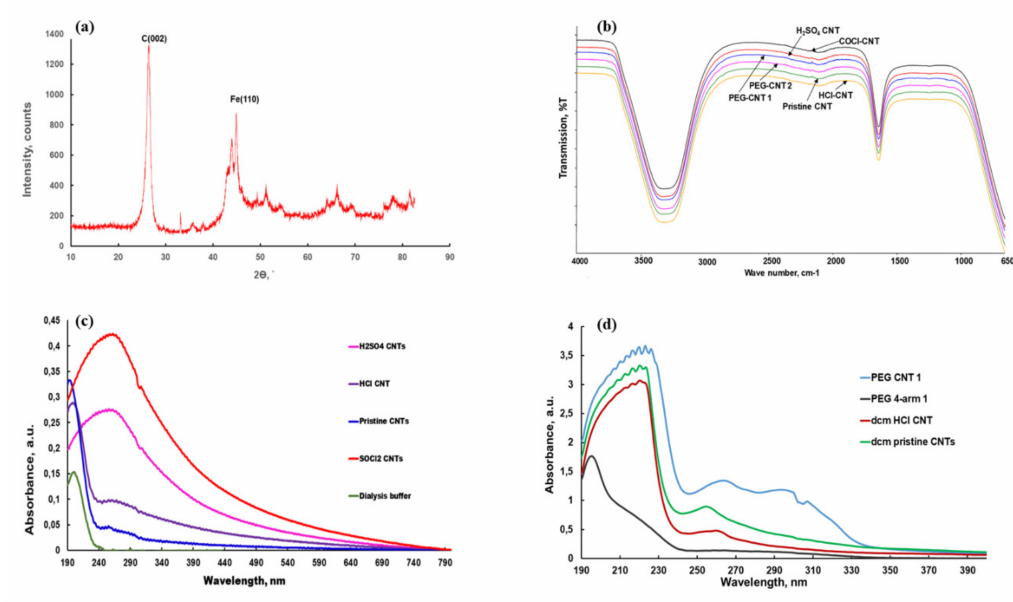
Figure 4. Si wafer XRD and IR spectra of VA-MWCNTs. XRD spectrum of Si wafer ( a ), universal attenuated total reflectance (UATR)-IR spectra of CNTs in water ( b ), UV-Vis spectra of carboxylated MWCNTs ( c ) and UV-Vis spectra of the PEGylated MWCNTs ( d